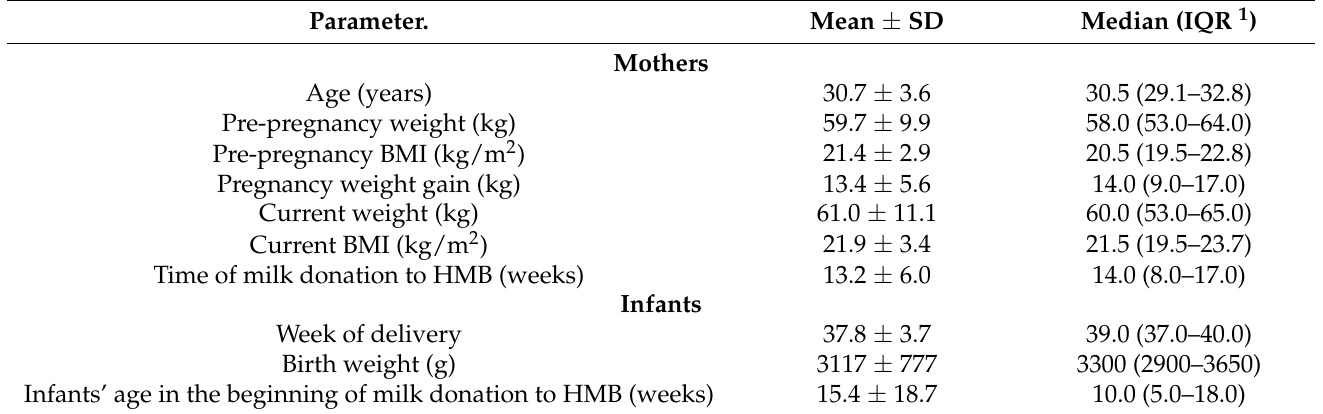
Table 1. The descriptive characteristics of the mothers and infants.